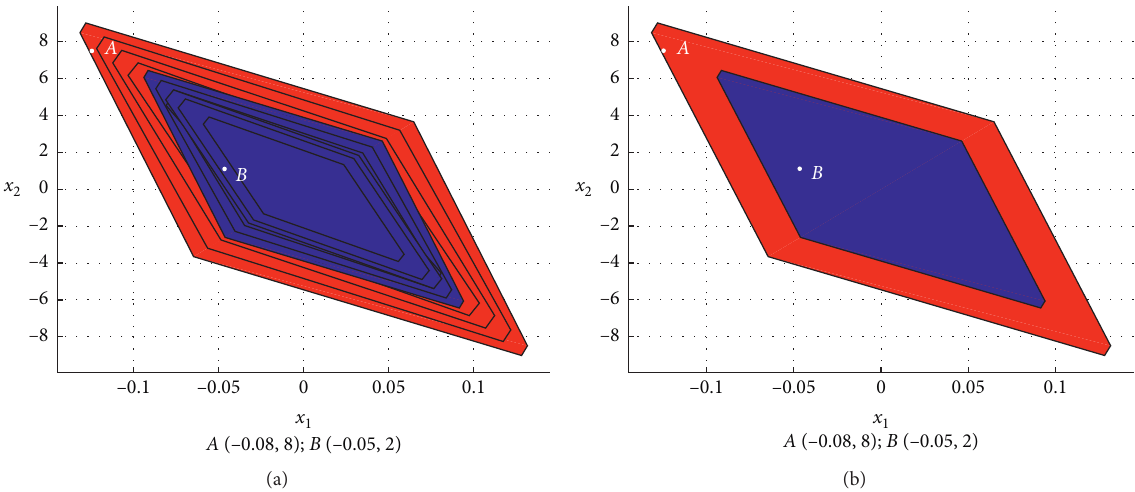
Figure 3: Examples of maximized polyhedral invariant sets from (a) six imprecated sets and (b) first set compared to